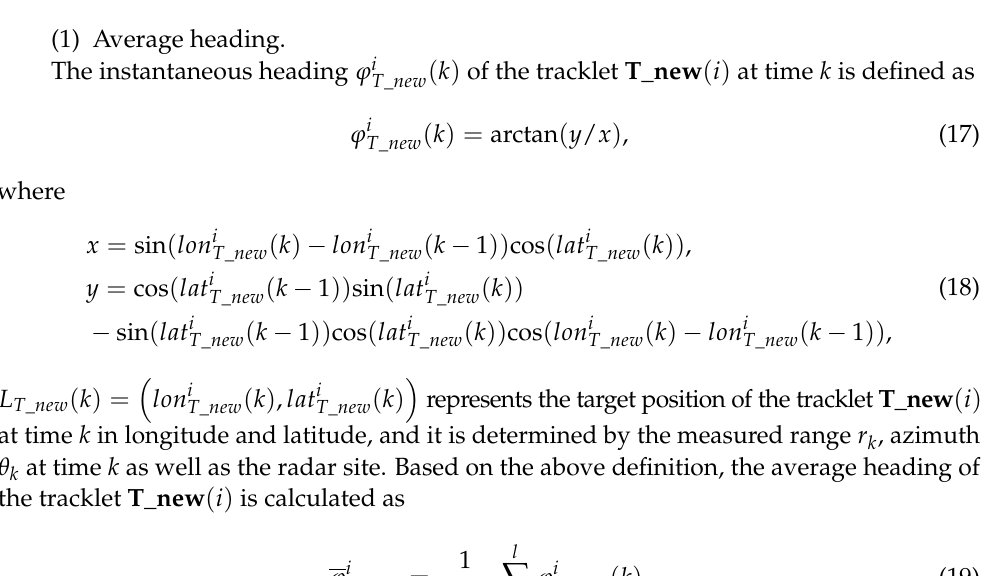
Figure 1. An illustrative comparison between the instantaneous heading and average